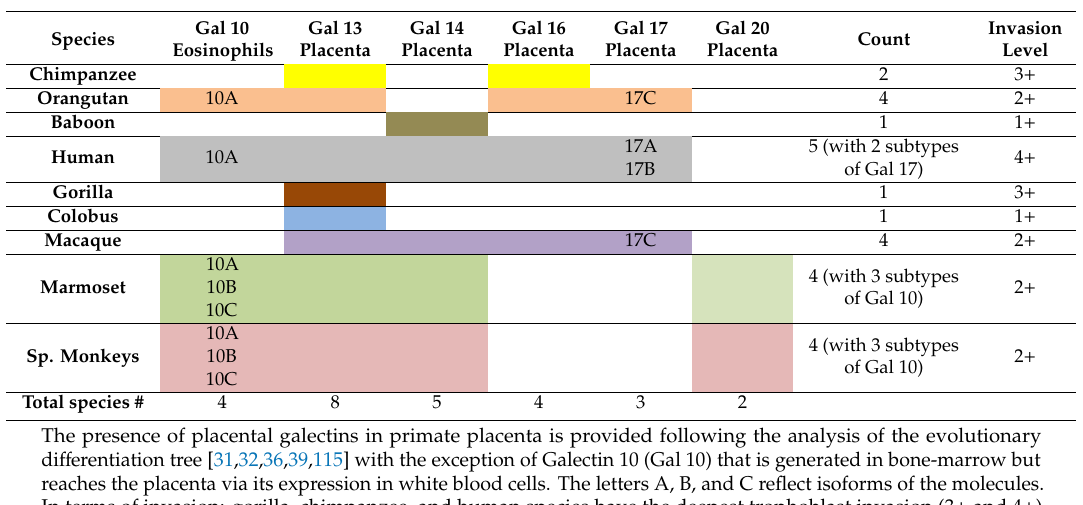
Table 1. Placental galectins in